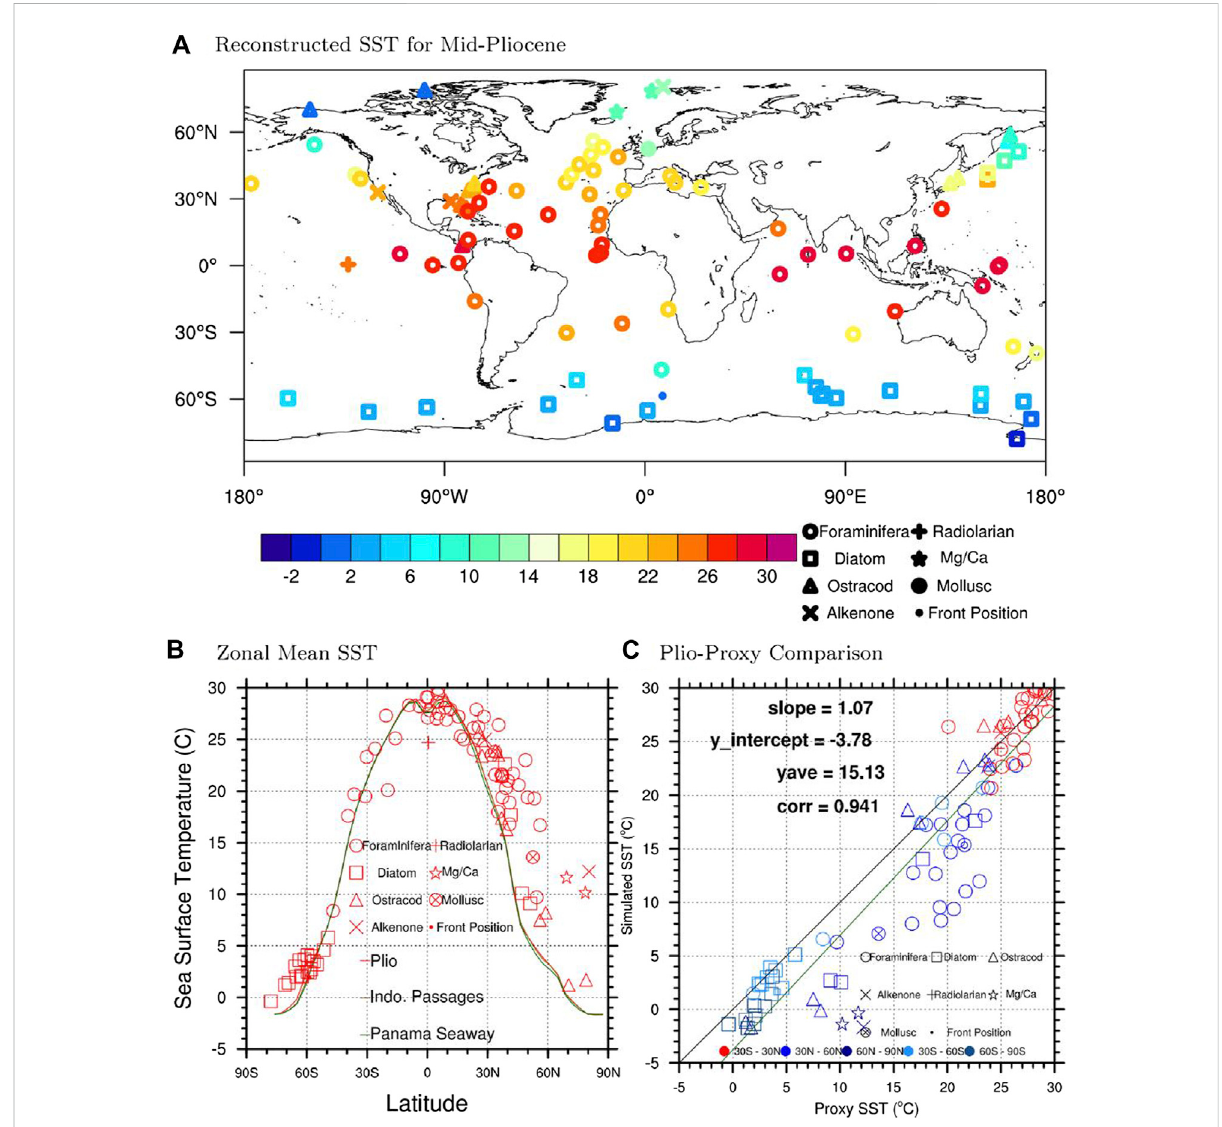
FIGURE 3 Model-data comparison. (A) Mean annual SST from PRISM dataset at 95 sites. (B) SST proxies superimposed on zonally averaged annual mean SST from three high-CO2 simulations. (C) Scatter plot showing the comparison between PRISM3 SSTs and the simulated annual mean SSTs in Plio. The Plio SSTs are interpolated to each proxy